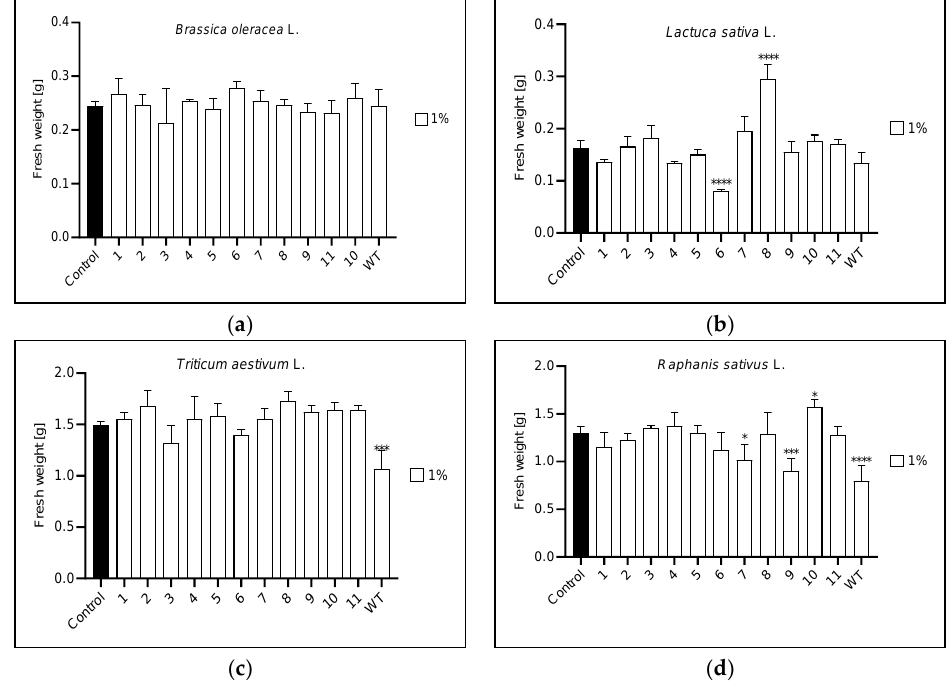
Figure 11 . Fresh weight of broccoli ( a ), lettuce ( b ), wheat ( c ), and radish ( d ) sprouts treated with 1% concentration for all algae clones tested (1-11, WT) and control (Control). Values represent mean ± SD, n = 10 plants, * p < 0.1, *** p < 0.001, **** p < 0.0001 compared to control (ANOVA and Dunnett ’ s a posteriori test).